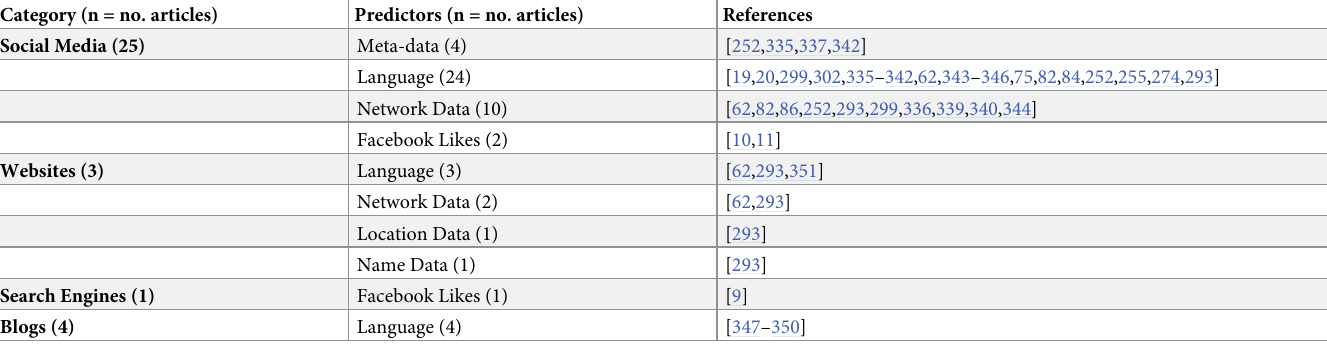
Table 8. Number of articles predicting political orientation, with associated predictors and references. Category (n = no.